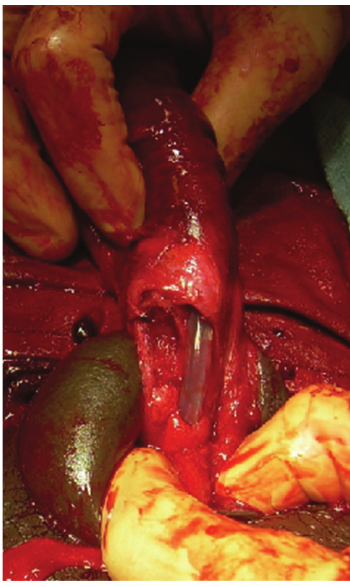
Figure 2: Intraoperative findings: right cavernosal tear and urethral rupture (foley catheter in urethra).